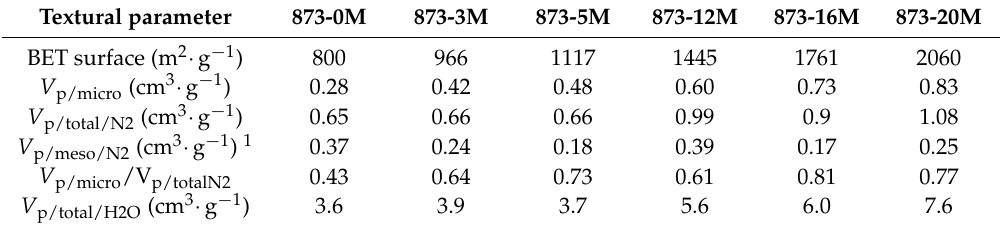
Table 2. Textural data of carbons obtained from char carbonized at 873 K.